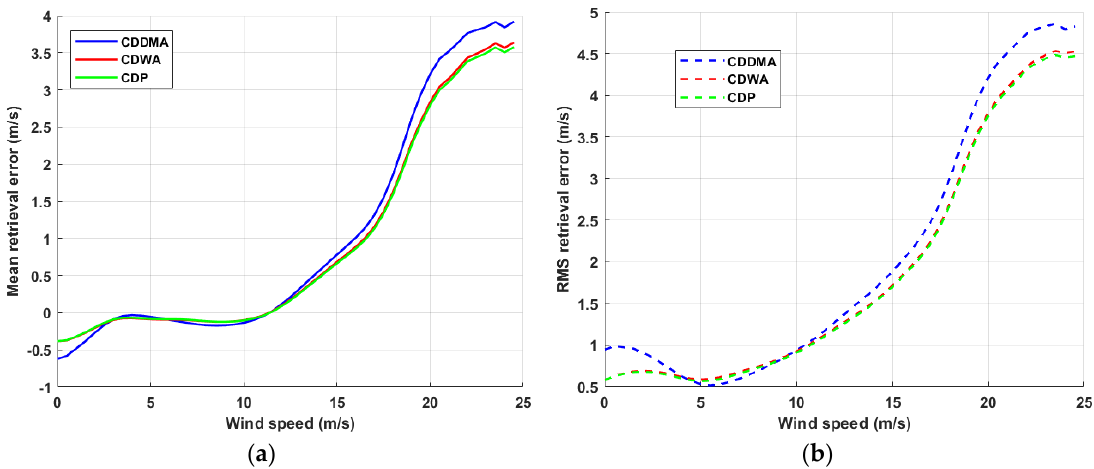
Figure 13. ( a ) Mean and ( b ) RMS retrieval error versus ground-truth wind speed for (blue) cDDMA, (red) composite delay-waveform average (cDWA), and (green) cDDM peak (cDP).